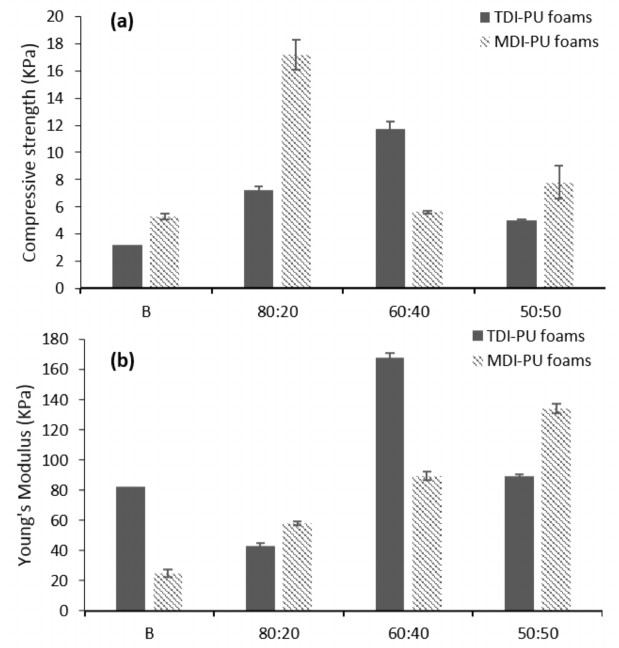
Figure 2. Mechanical properties of LWS-formulated PU foams: ( a ) Compressive strength and ( b ) Young’s